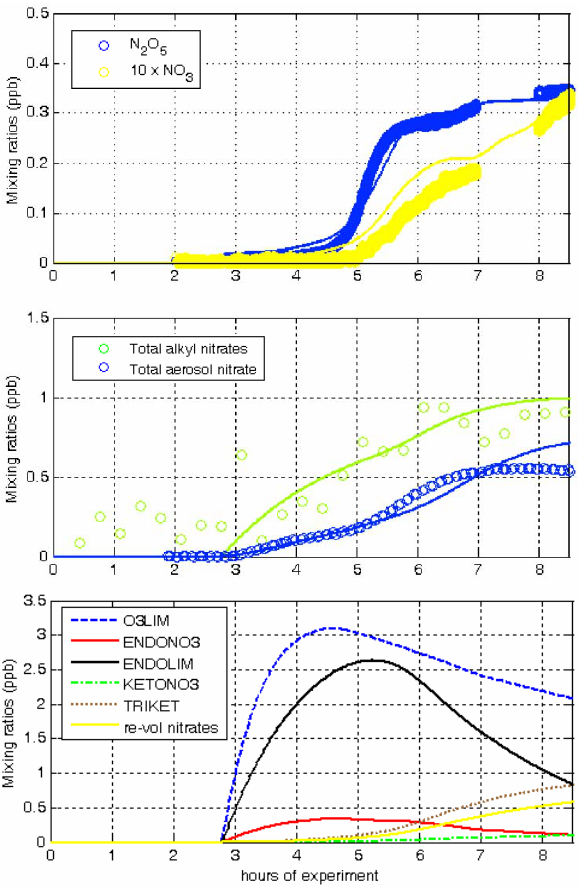
Fig. 4. Measured (markers) and modeled (lines) time traces after the first limonene injection. Bottom panel shows the major products modeled.